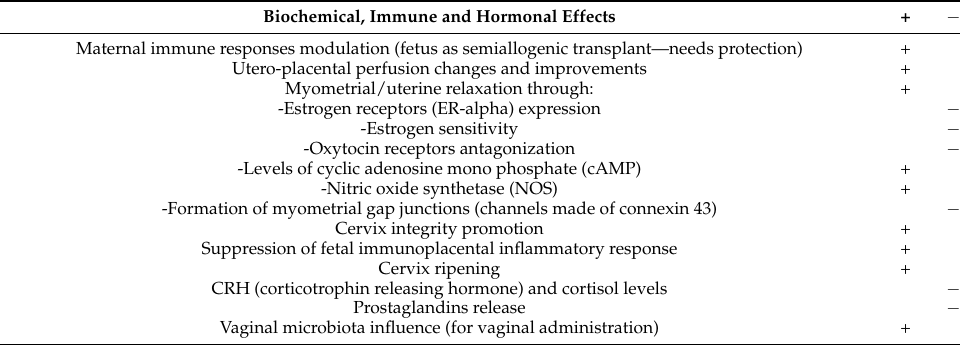
Table 2. Pharmacodynamic identikit of progesterone in pregnancy maintenance